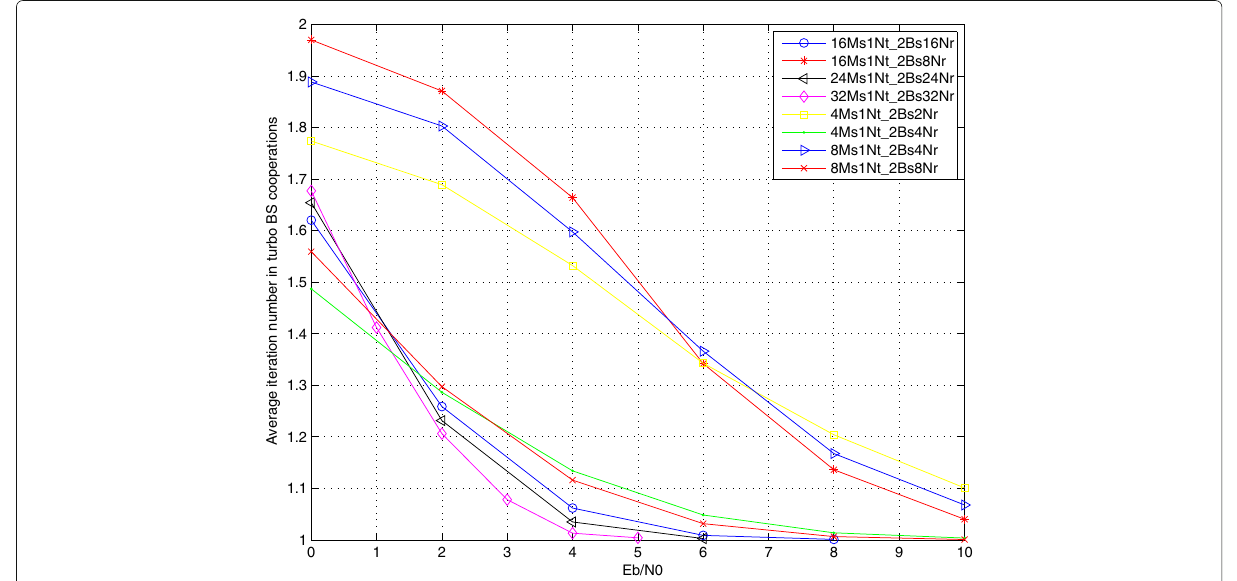
Fig. 8 Average turbo iteration number in PDA-TB